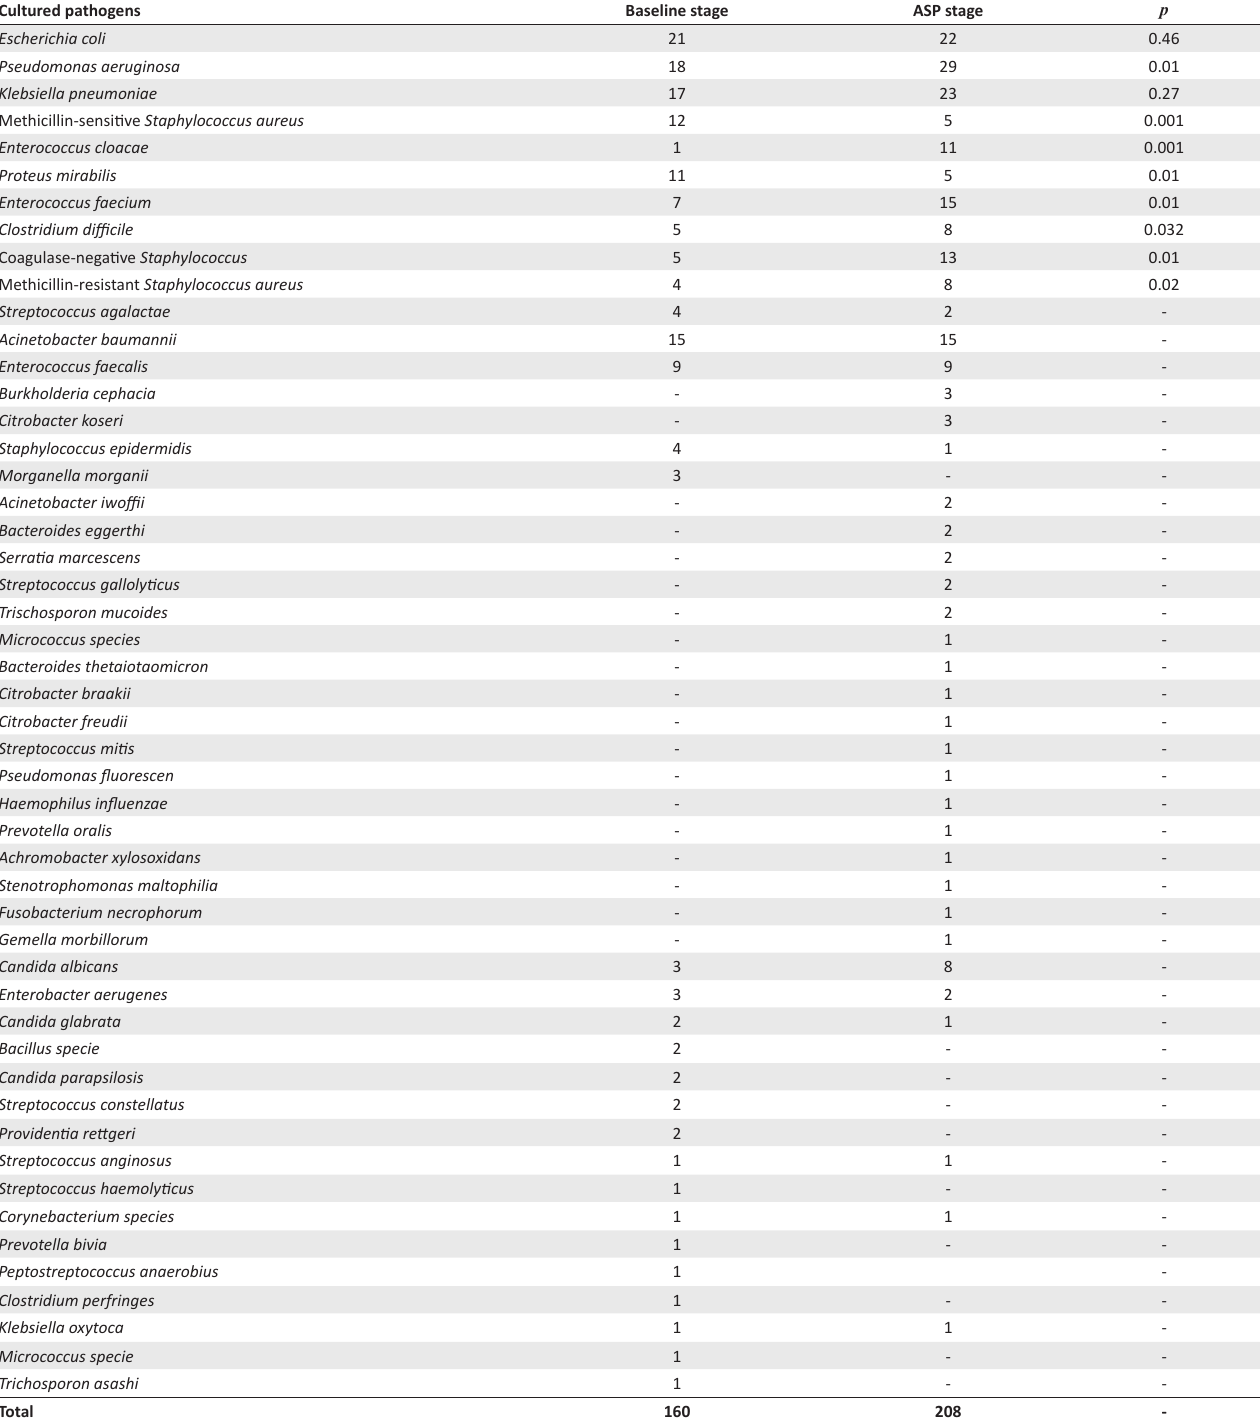
TABLE 1-A2: Pathogens isolated in the two stages of the study. Cultured